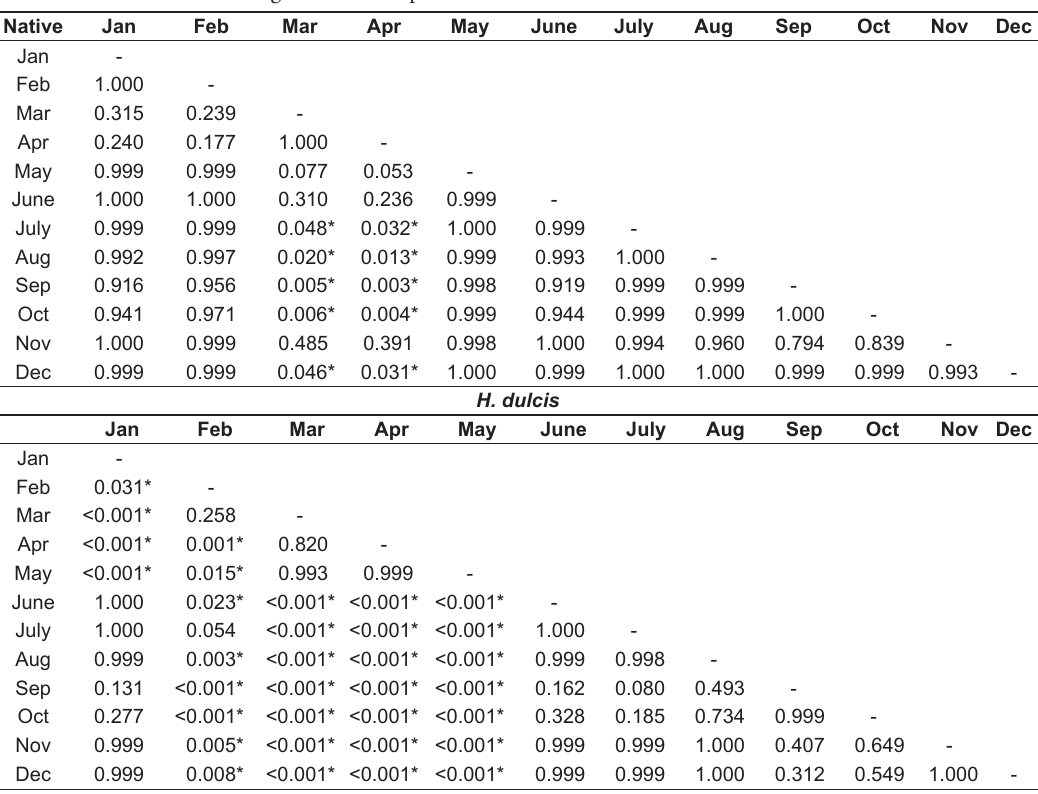
Table 2. Results of Tukey test carried a posteriori of the Analysis of Variance (two way ANOVA) to verify the differ- ence of native and H. dulcis organic matter input between the months.